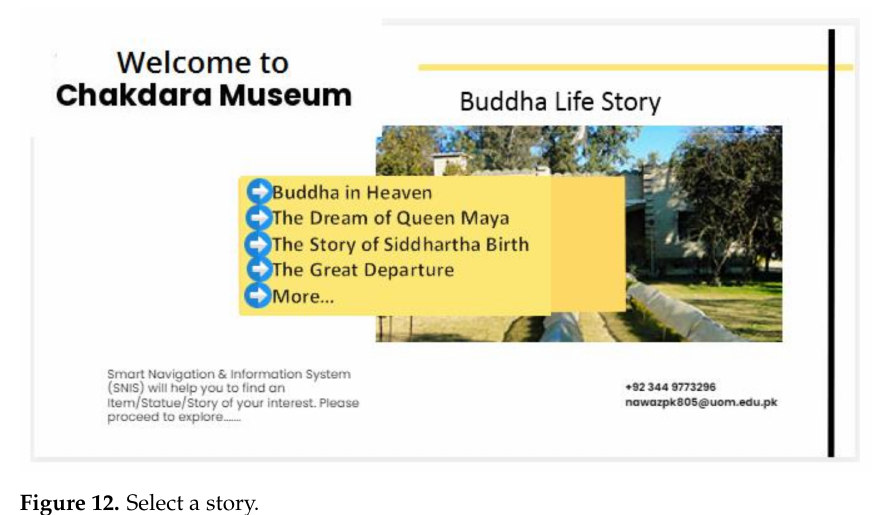
Figure 12. Select a story.